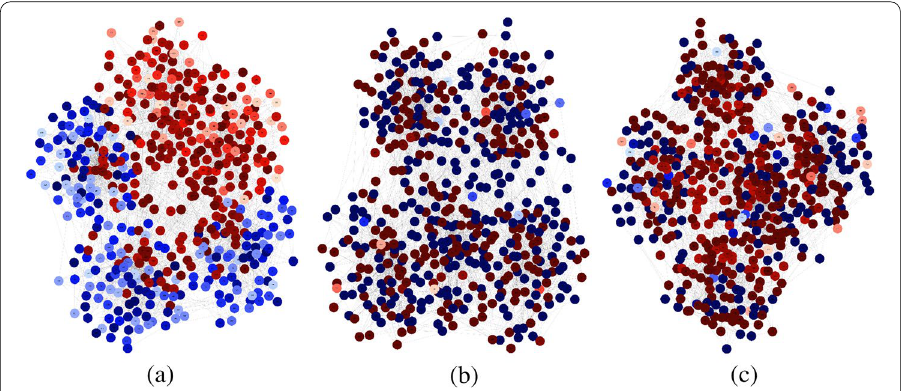
Fig. 9 Network visualizations with configuration B. a Nodes initial conditions - five communities, three prevalently negative (blue node), two positive (red nodes); b WHK G final equilibrium with random stubborn; c WHK G final equilibrium with stubborn as